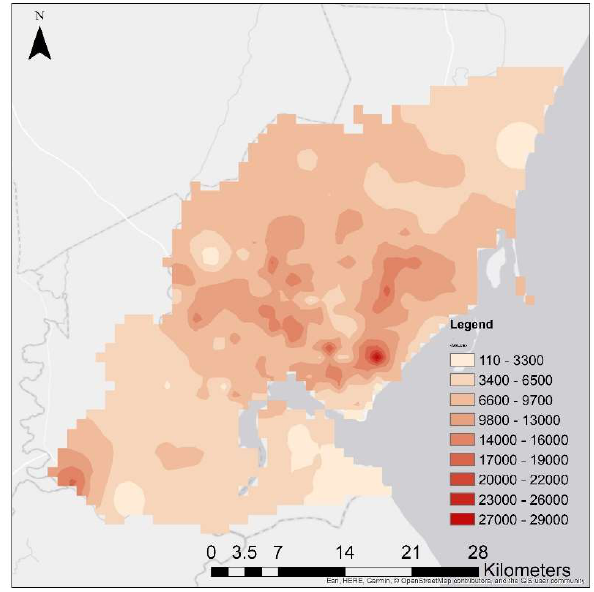
Figure 7. Subscriber distribution in the study area.